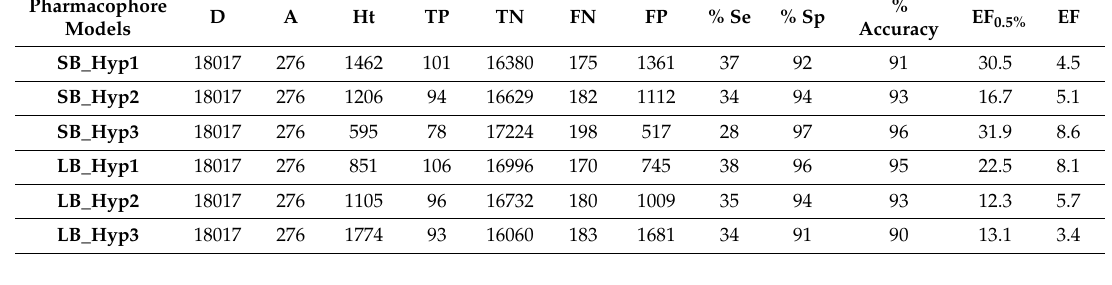
Table 3. Pharmacophore model validation using decoys. D: total number of compounds in the dataset. A: total number of active compounds in the dataset. Ht: total number of compounds retrieved by the model. TP: true positive. TN: true negative. FN: false negative. FP: false positive. Se: sensitivity. Sp: